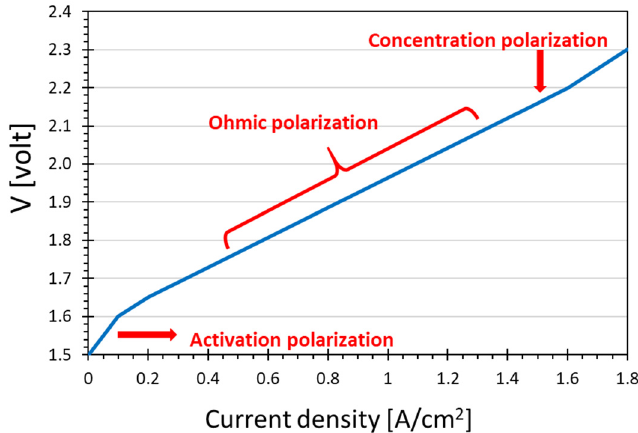
Figure 2. Typical polarization curve for a PEM